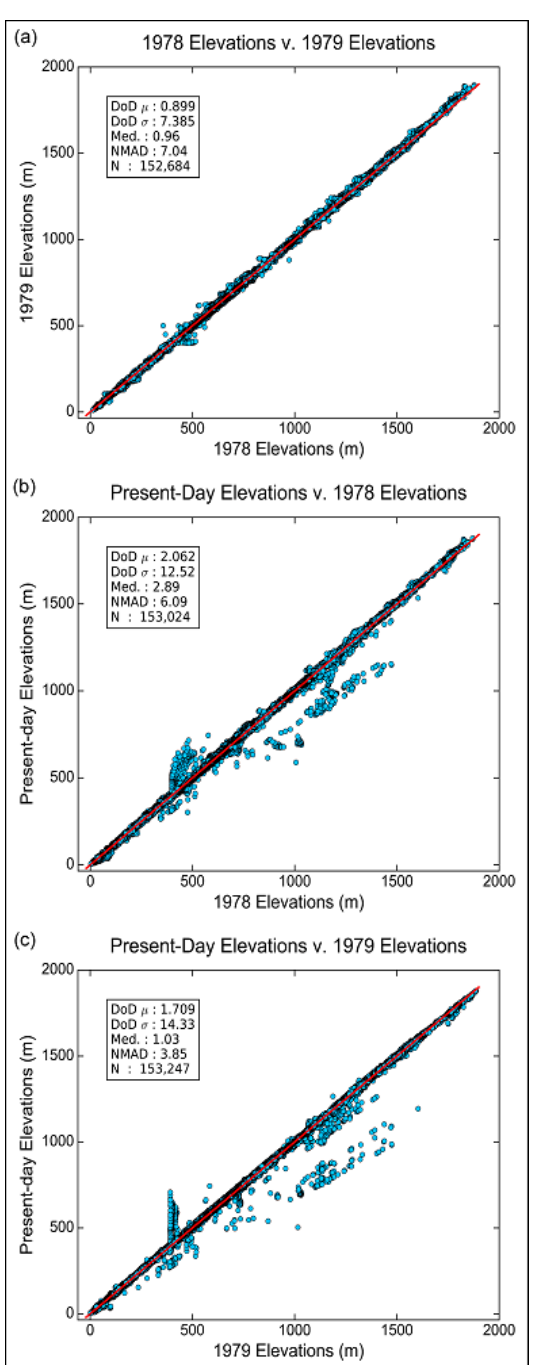
Figure 9. Stable terrain elevation scatter plots for 1978 vs. 1979 DEMs ( a ) 1978 vs. present-day DEMs ( b ), and 1979 vs. present-day DEMs. ( c